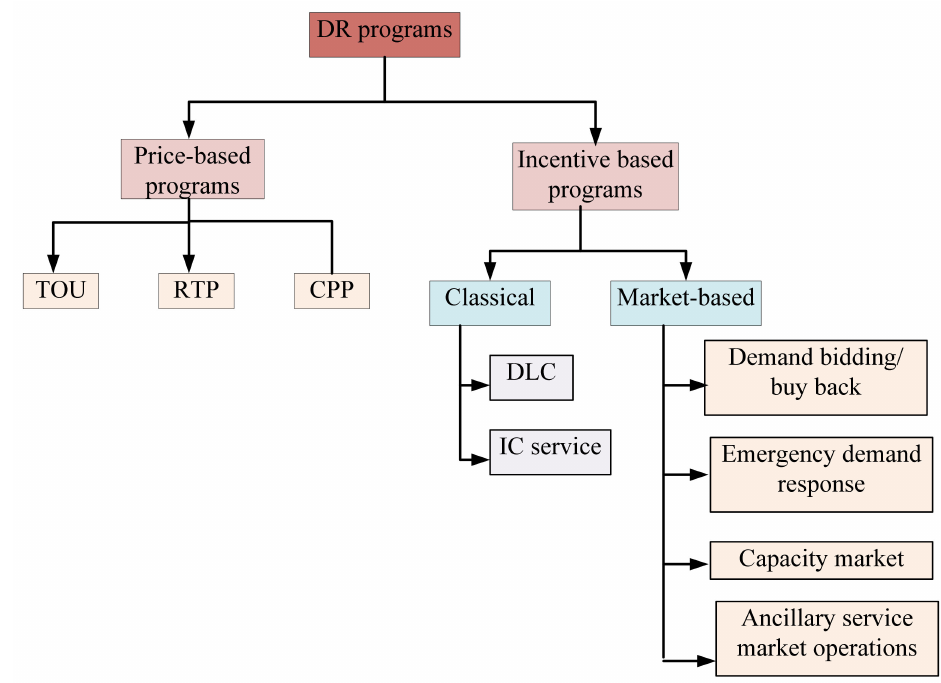
Figure 7. Methods to perform EM in the MG system from the load end.